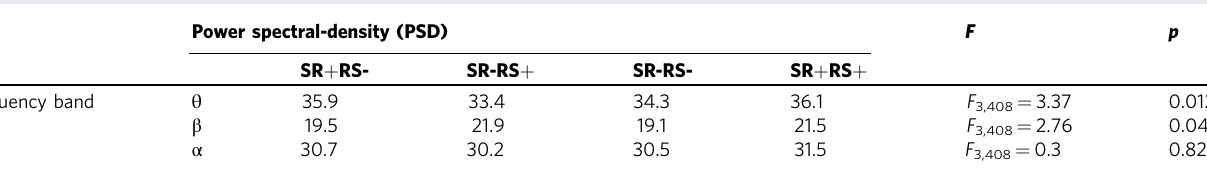
Table 2 Comparison of PSDs between channel types SR + RS-, SR-RS + , SR-RS-, and SR + RS + channels, respectively, each for the three frequency bands θ , β , and α based on the interaction between both